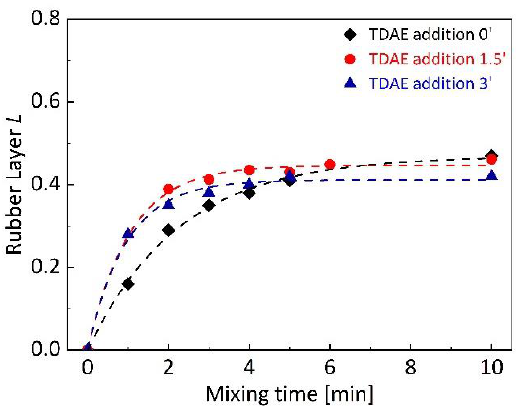
Figure 1. Mixing torque and temperature curves versus total mixing time for silica-filled styrene– butadiene rubber (SBR)/butadiene rubber (BR) binary blends with 5 phr Treated Distillate Aromatic Extract (TDAE) content at different addition times.